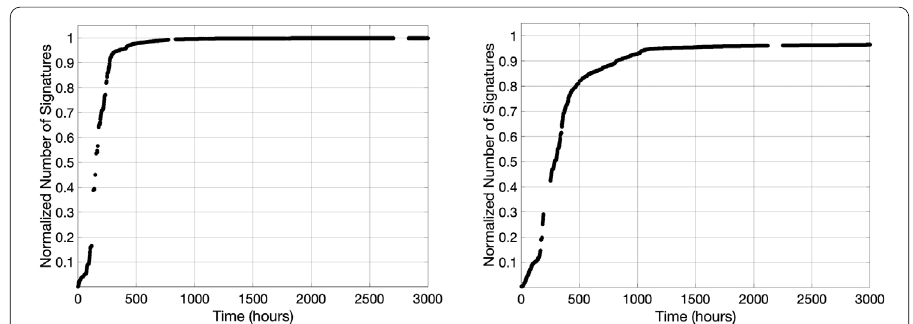
Figure 3 Growth of the number of signatures for 2 example petitions. Left panel: ‘Stop the badger cull’ and right panel: ‘Reconsider West Coast Mainline franchise